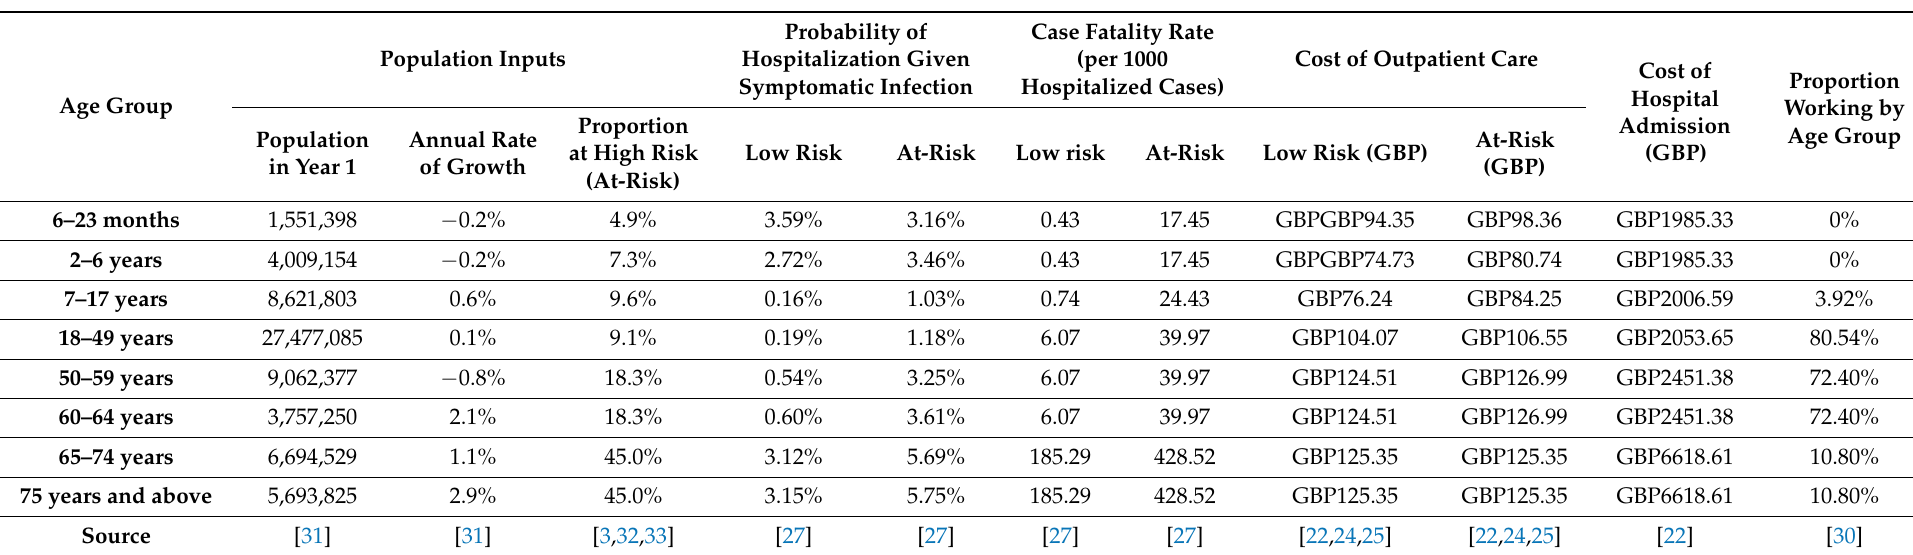
Table 2. Key population and economic model